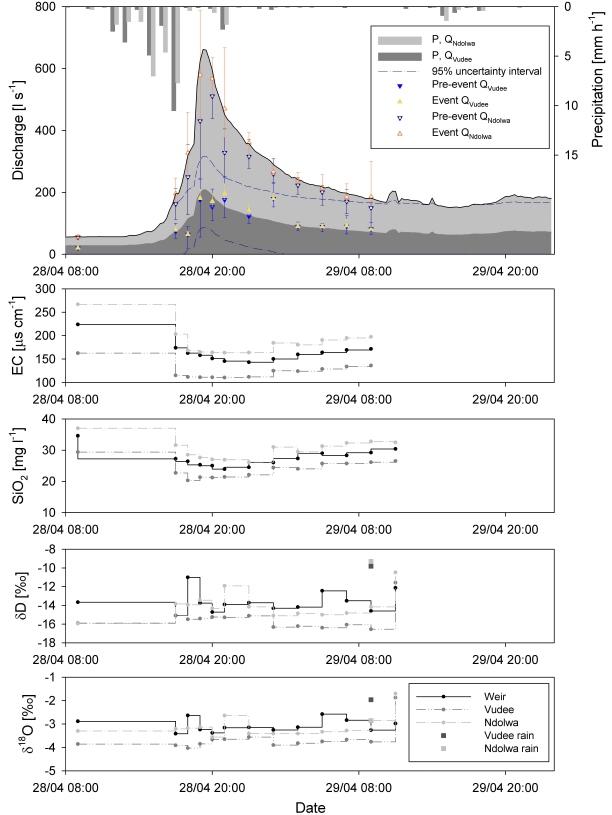
Figure 9. Top figure shows hydrograph separation between event (Q e ) and pre-event (Q p ) discharge from the Vudee (Q vud ) and Ndolwa (Q Ndol ) catchments for the B17 event (28/04/2008) of the Masika’08 season. Contributions from Q vud and Q Ndol estimated using combined EC and SiO 2 measurements. Separation into Q e and Q p based on combined δ D and δ 18 O measurements. The bold black line (-) shows the total discharge (Q tot ) observed at the Bangalala weir, the two grey shaded areas represent the central estimates for the contributions from the Vudee ( (cid:1) ) and Ndolwa ( (cid:1) ) catchments derived from a power relationship between Q tot and Q vud and the dashed line (--) is the corresponding 95% uncertainty interval. The yellow ( ▲ ) and light blue triangles ( (cid:1) ) denote Q e and Q p contributions from Q vud , while the orange ( ▲ ) and dark blue triangles ( (cid:1) ) represent the Q e and Q p contributions from Q Ndol for the individual analyzed samples, with the whiskers representing the 95% uncertainty interval.